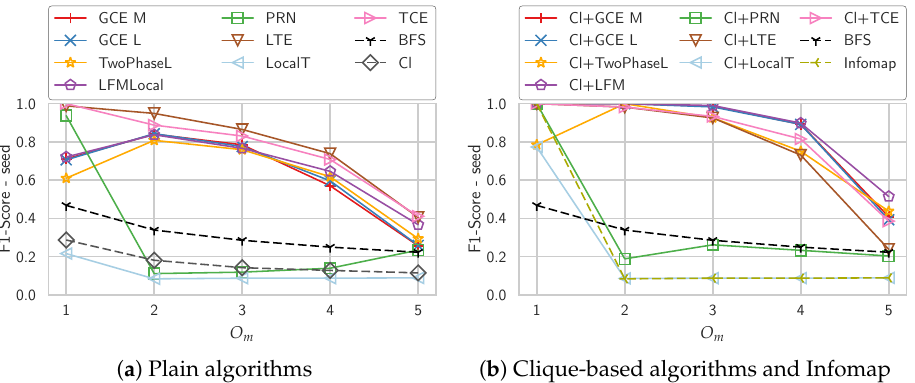
Figure 3. Results for overlapping communities with LFR graphs with parameter set “Overlapping” as specified in Table